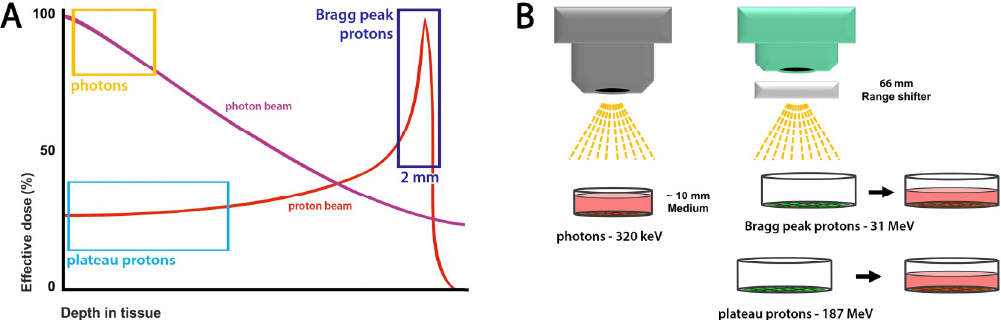
Figure 1. The relation between tissue depth and delivered dose of the different beams. ( A ) Depth dose curves of a photon beam and a proton beam highlighting the areas where the cells were irradiated with photons, Bragg-peak protons and plateau protons. ( B ) Experimental set-ups to simulate different tissue depths and radiation types for a photon beam, a Bragg-peak proton beam and a plateau proton beam. The cells were irradiated to a total dose of 3 Gy with each type of radiation calibrated using ionization chamber measurements at the same depth as the cells.